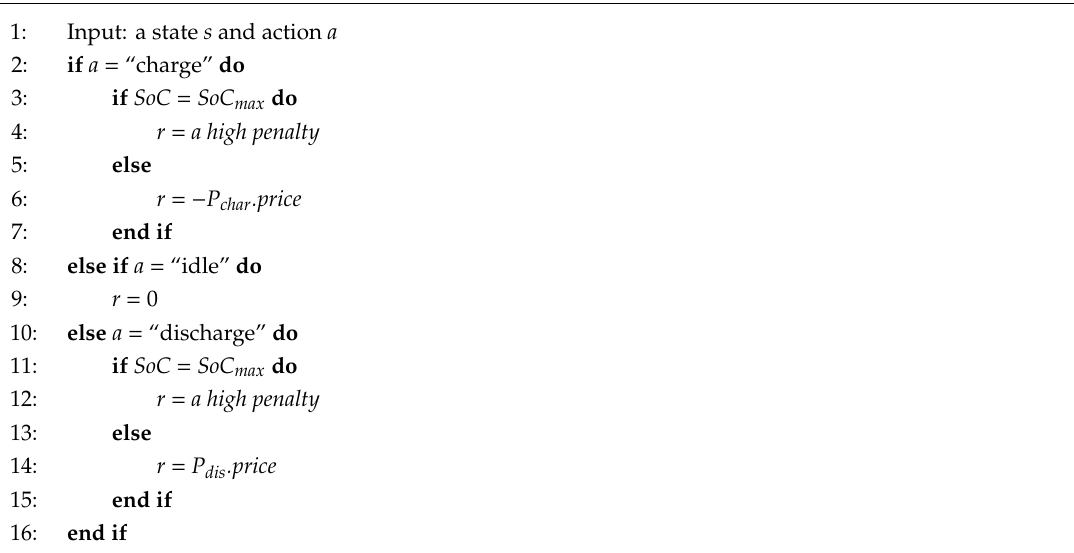
Algorithm 1: Reward Function for CBESS